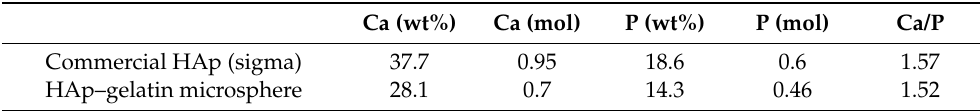
Table 1. Ca content, P content, and Ca/P atomic ratio of the commercial HAp and the prepared HAp–gelatin microspheres obtained from ICP–MS analyses. Ca